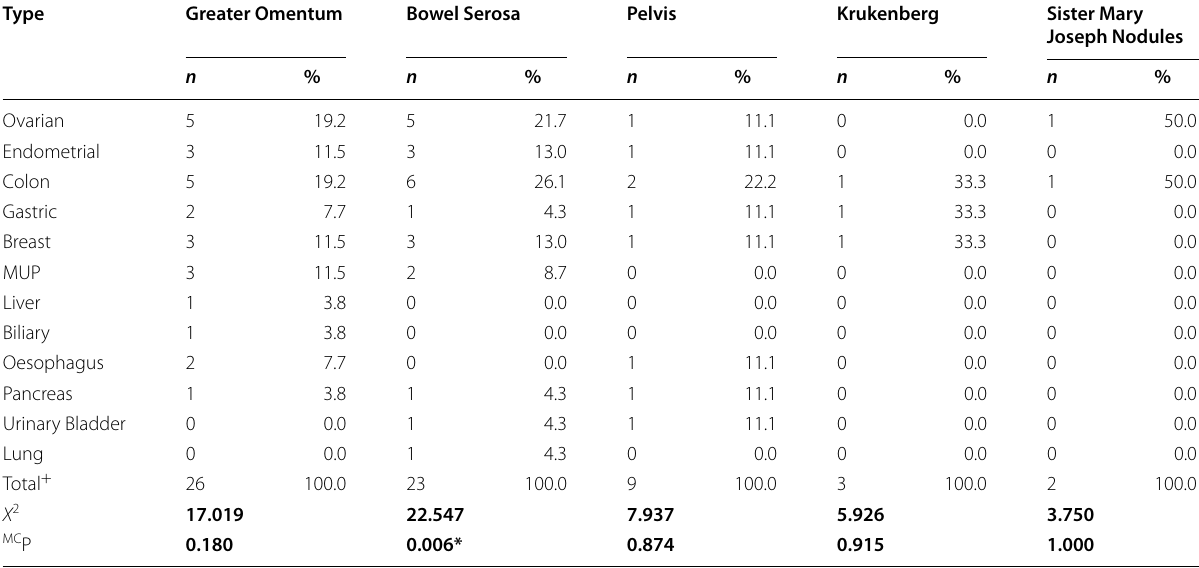
Bold indicates X 2 : Chi-square test, MC: Monte Carlo exact test Data expressed as frequency ( n and %); MUP Metastases of unknown primary; + Most of the included patients showed more than one site of peritoneal metastasis; p probability; *, significance < 0.05